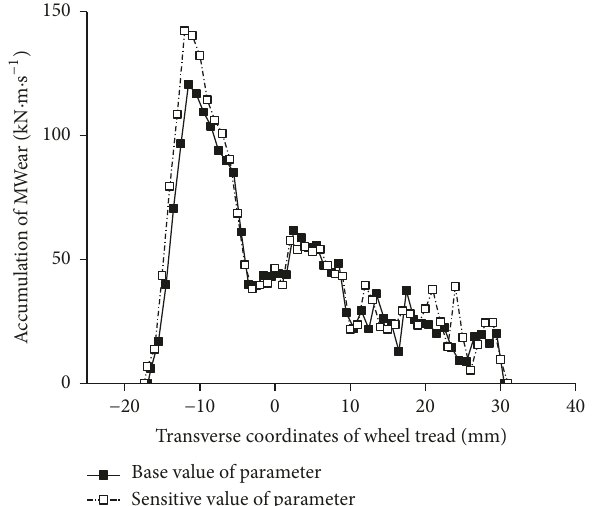
Figure 8: Influence of vertical damping of the track on the cumulative wear power dissipation of the wheel.